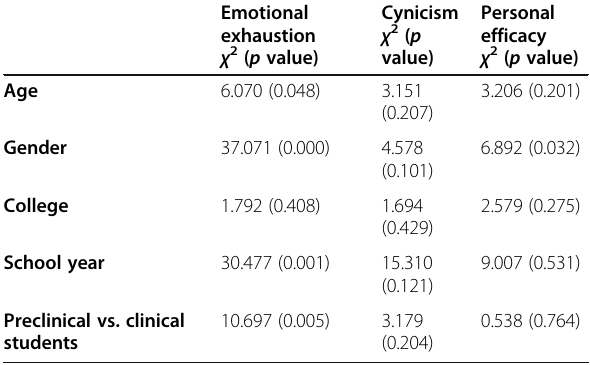
Table 5 Comparison of differences in the MBI-SS subscales according to students ’ demographics (using the chi-square test ( χ 2 ) (2-sided))